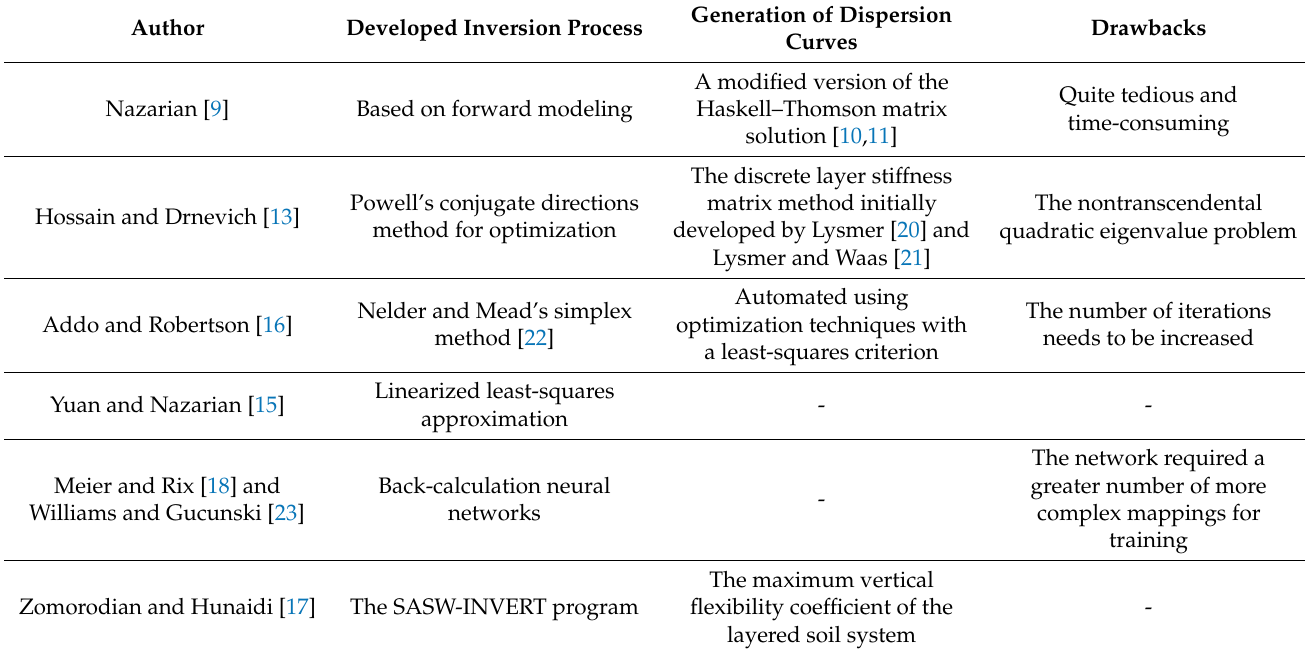
Table 1. Studies related to SASW inversion